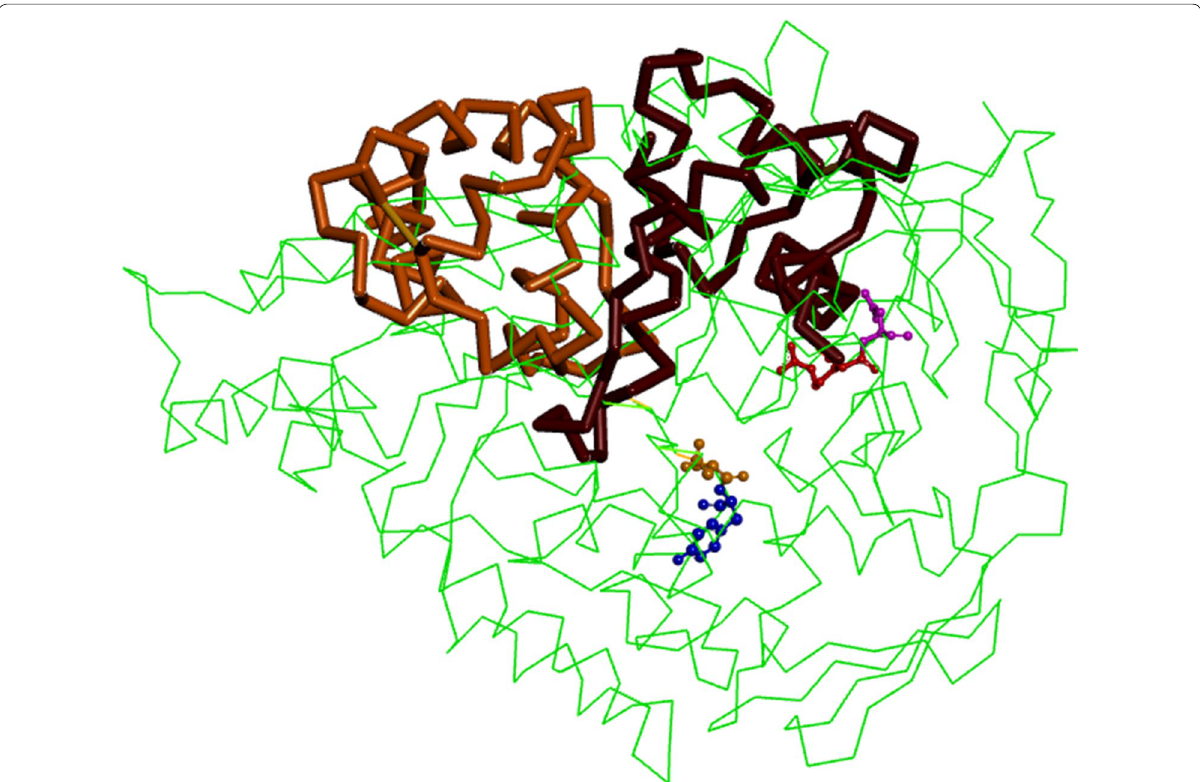
Fig. 3 Overlay of Yersinia pestis OppA PDB:2Z23 (green color) and HdeA PDB:1DJ8 (in light brown color the monomer a , in dark brown color the monomer b ). The amino acids arginine 41 (red) and aspartate 42 (pink) affect the protein surface near to the hydrophobic cleft; amino acids aspartate 419 (orange) and tyrosine 420 (blue) are in the oligopeptide binding